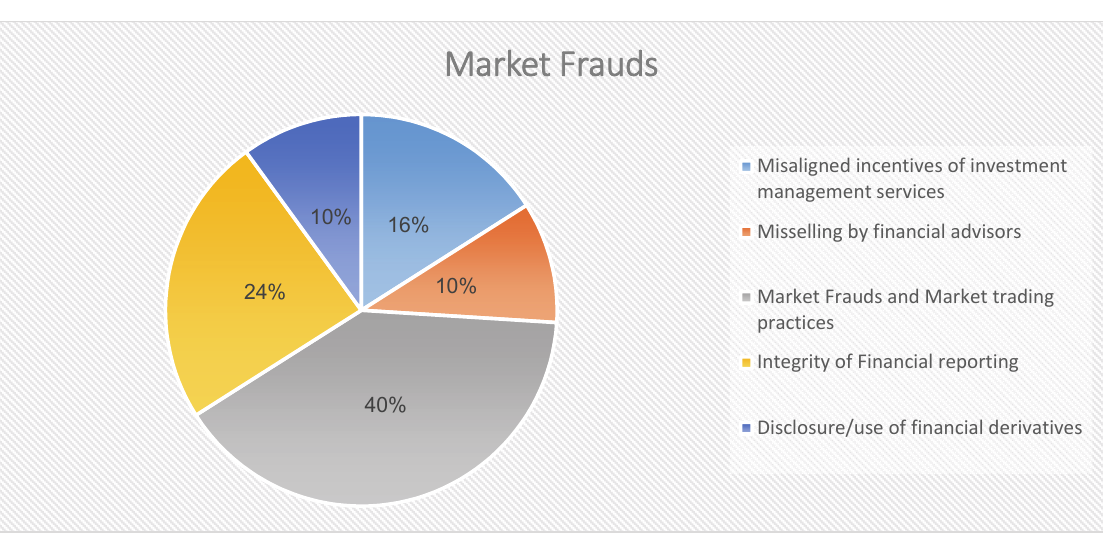
Fig. 1. Market Frauds